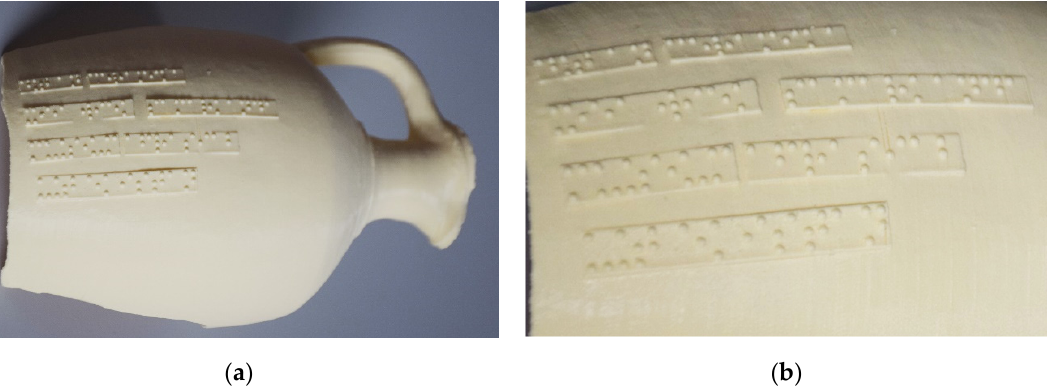
Figure 11. ( a ) A model of a jug with integrated descriptions in Braille; ( b ) the scales of the inscriptions in the following lines (starting from the top) were: 100%, 110%, 120% and 130%.